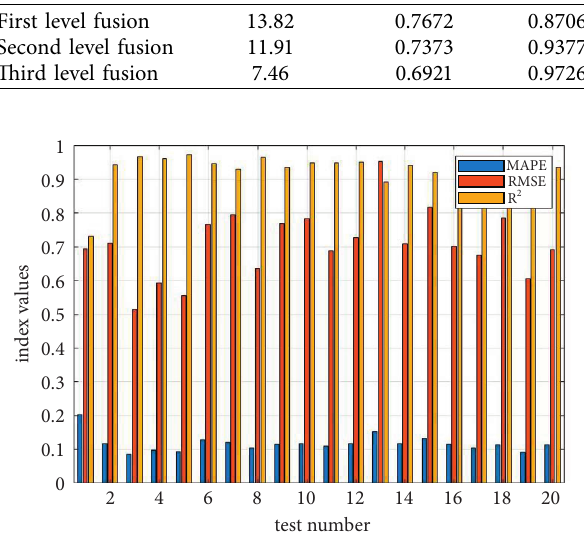
Figure 9: Comparison between fusion value and real value.